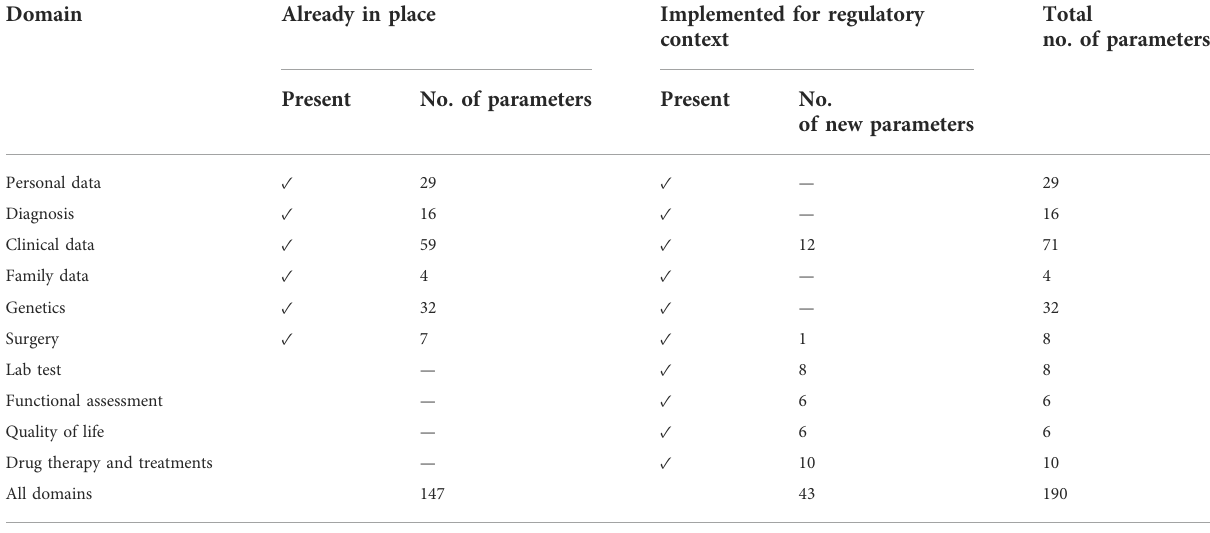
TABLE 2 Comparison between already-in-place domains and parameters versus new domains and parameters designed for RWE capturing in regulatory context.